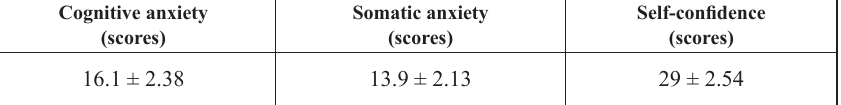
Table 5. Pre-Competitive Cogni- tive and Somatic Anxiety, Self- Confidence of Youth